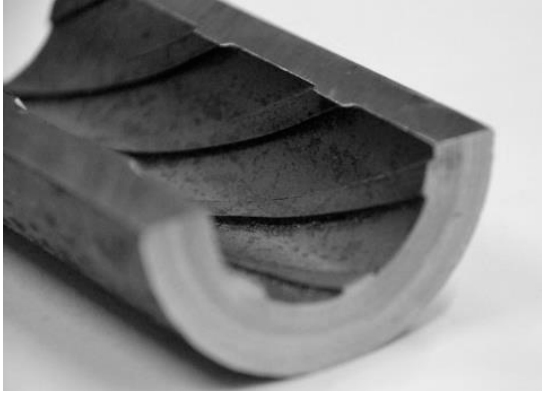
Figure 5. A cross-section of the tube with internal helical ribs.